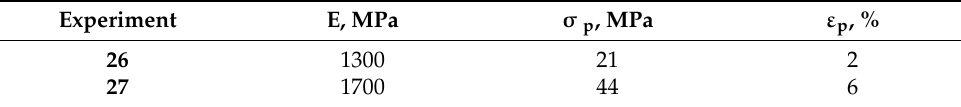
Table 8. Mechanical characteristics of polymers 26 – 27